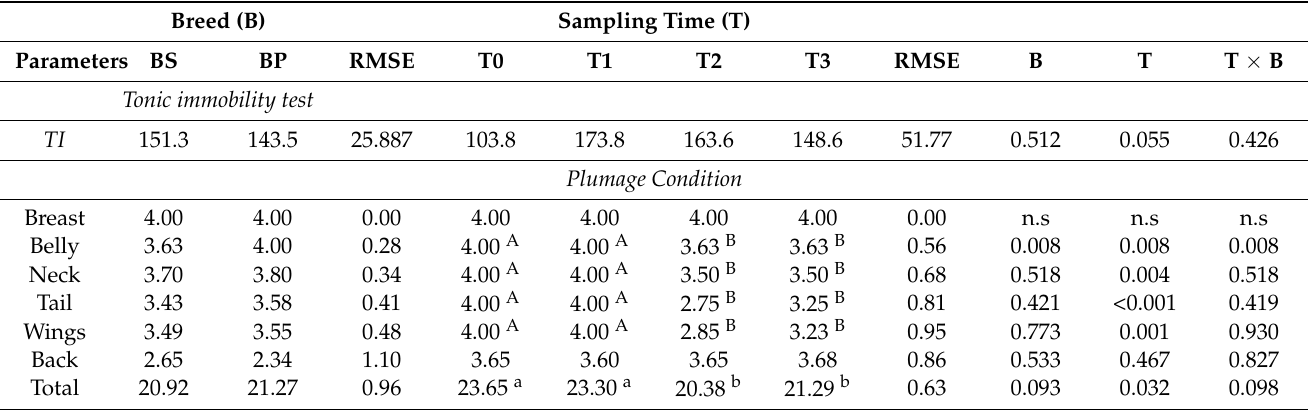
Table 1. Effect of regrouping on tonic immobility test (TI) and plumage conditions in Bianca di Saluzzo (BS) and Bionda Piemontese (BP) laying hens according breed and sampling time (n = 24). Breed